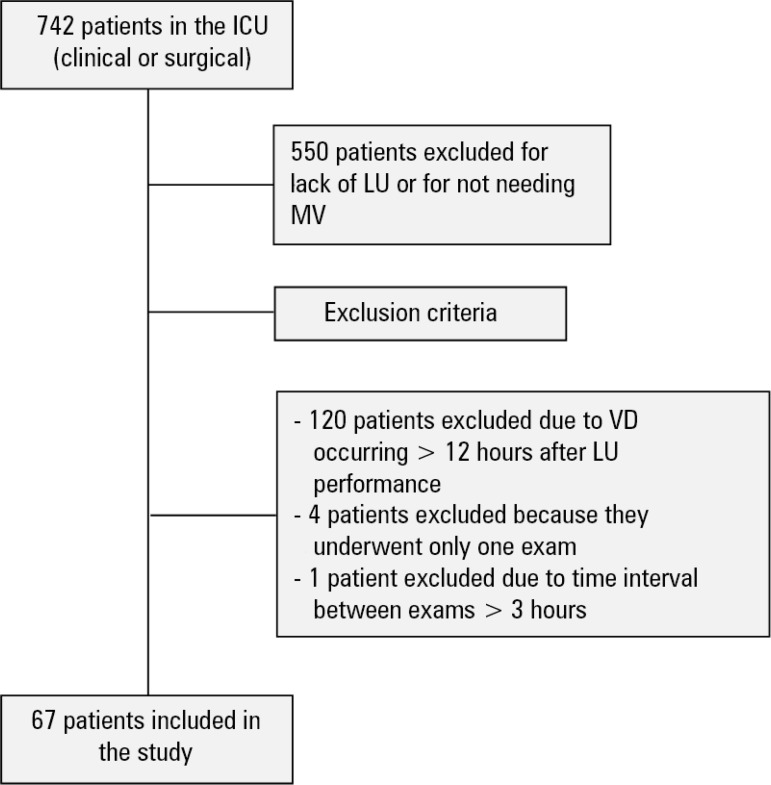
Flowchart of the exclusion criteria.ICU - intensive care unit; VD - ventilatory deterioration; MV - mechanical ventilation; LU - lung ultrasound.